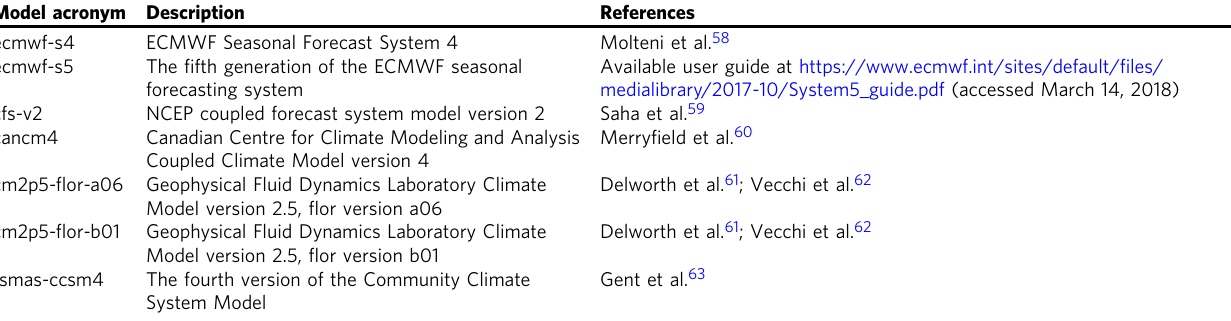
Table 1 Seasonal forecast systems considered in this study Model acronym Description